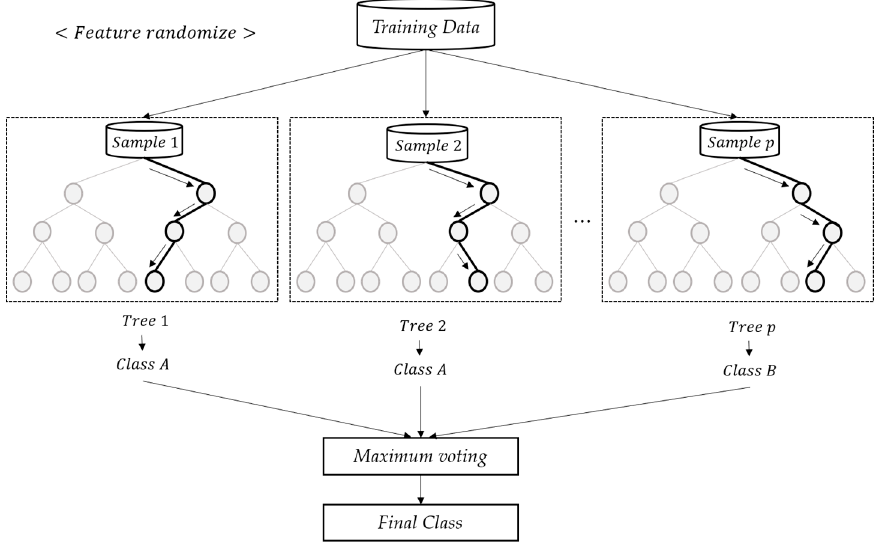
Figure 1. Random Forest Diagram.